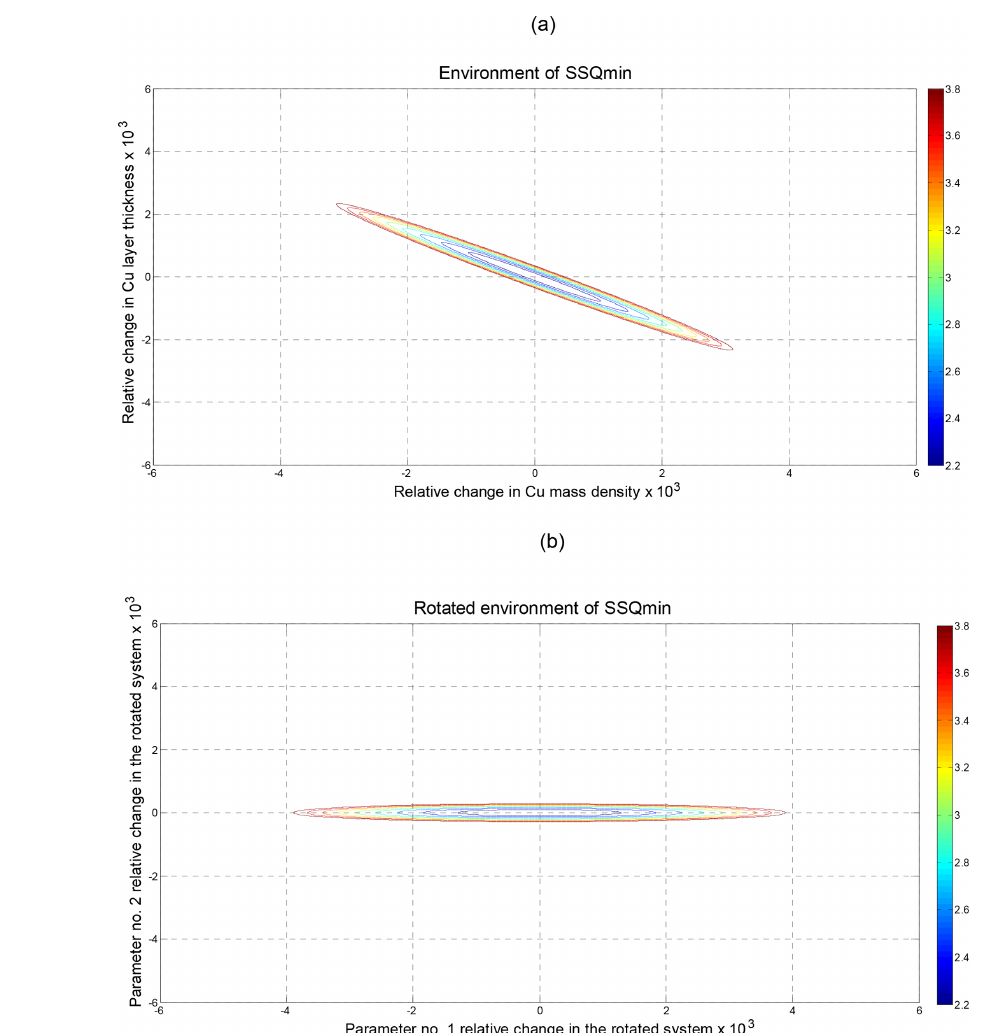
Figure 7. (a) Example of ellipses in the plane of two material–geometry parameters created by constant SSQ > SSQ min . Material system: AT-cut quartz TSM resonator with a 5µm thick Cu layer that is in contact with glycerol. The varied material parameters are mass density and thickness of the Cu layer. The incorporated measurements are the resonant and anti-resonant frequencies of the 3th and 5th overtones. (b) Ellipses aligned with the material–geometry parameter axes after the orthogonal transformation of the parameter